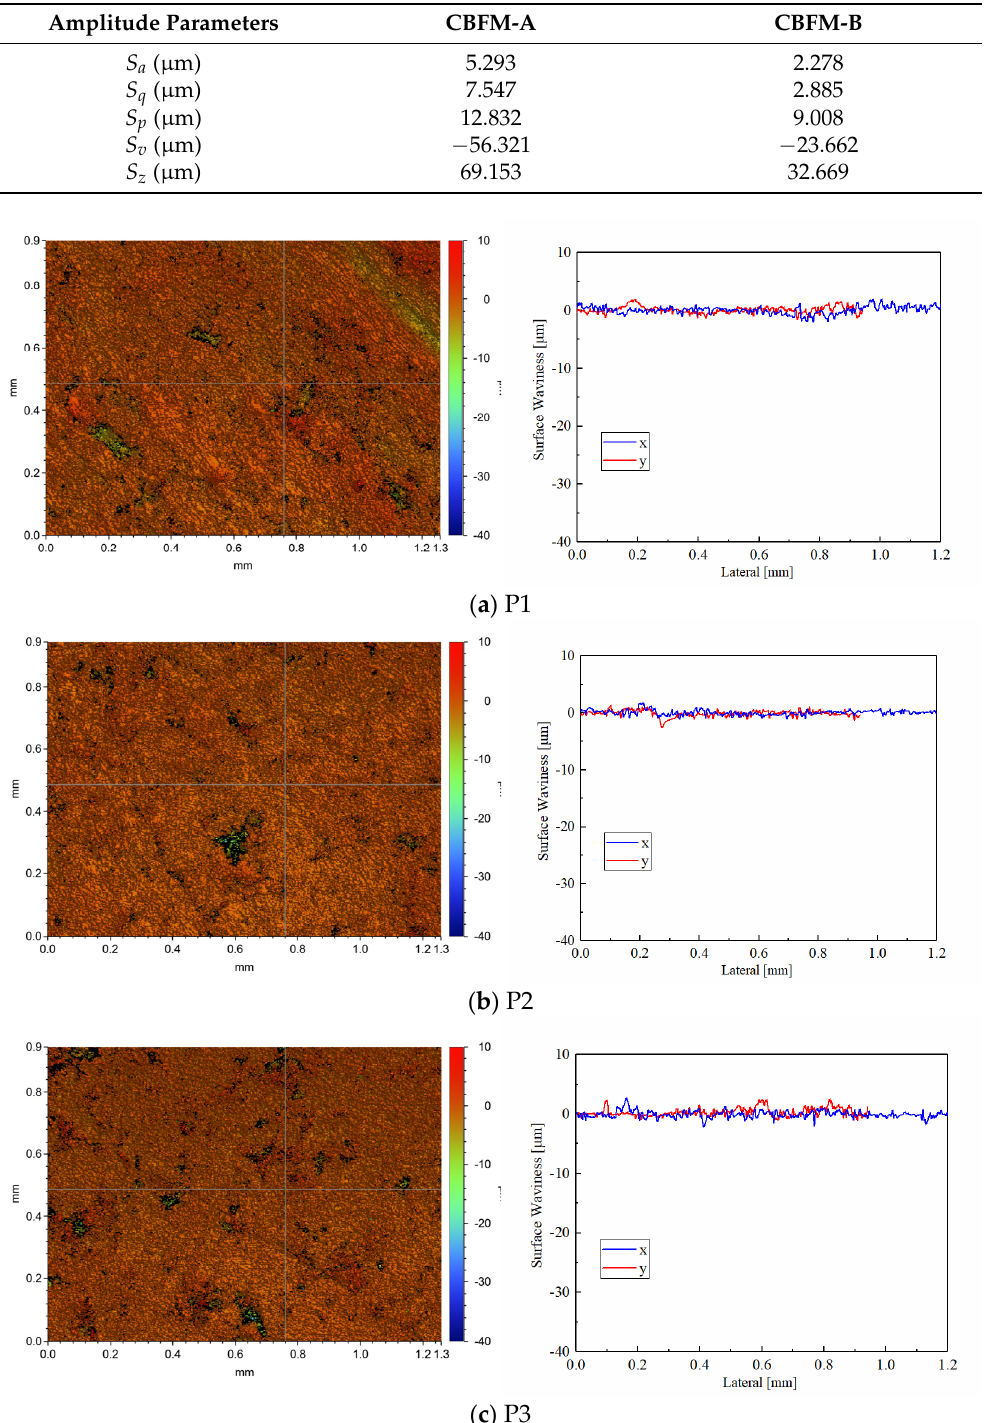
Figure 13. The post-test white light interferometric profilometry ( a – c ) (×50) of the test sample CBFM-B.